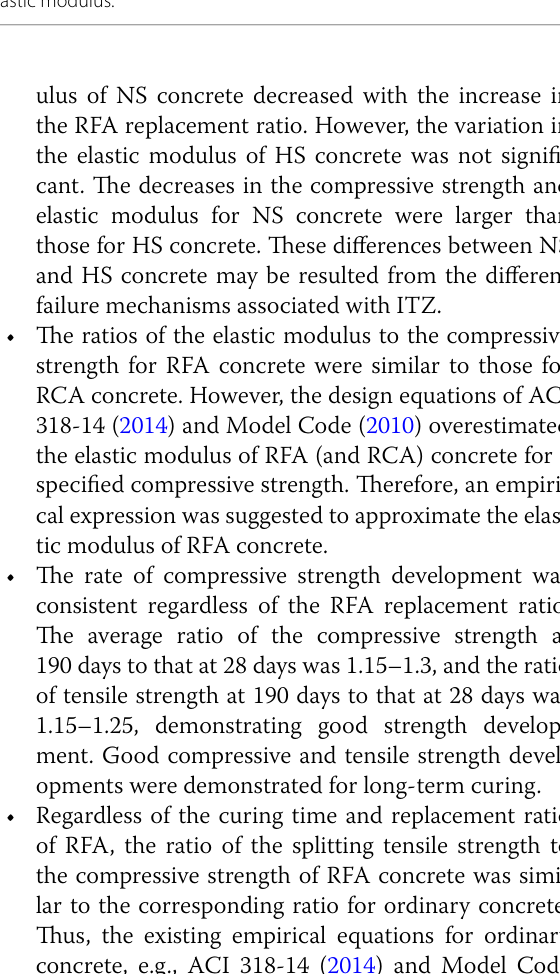
Fig. 10 Relationship between the compressive strength and the measured elastic